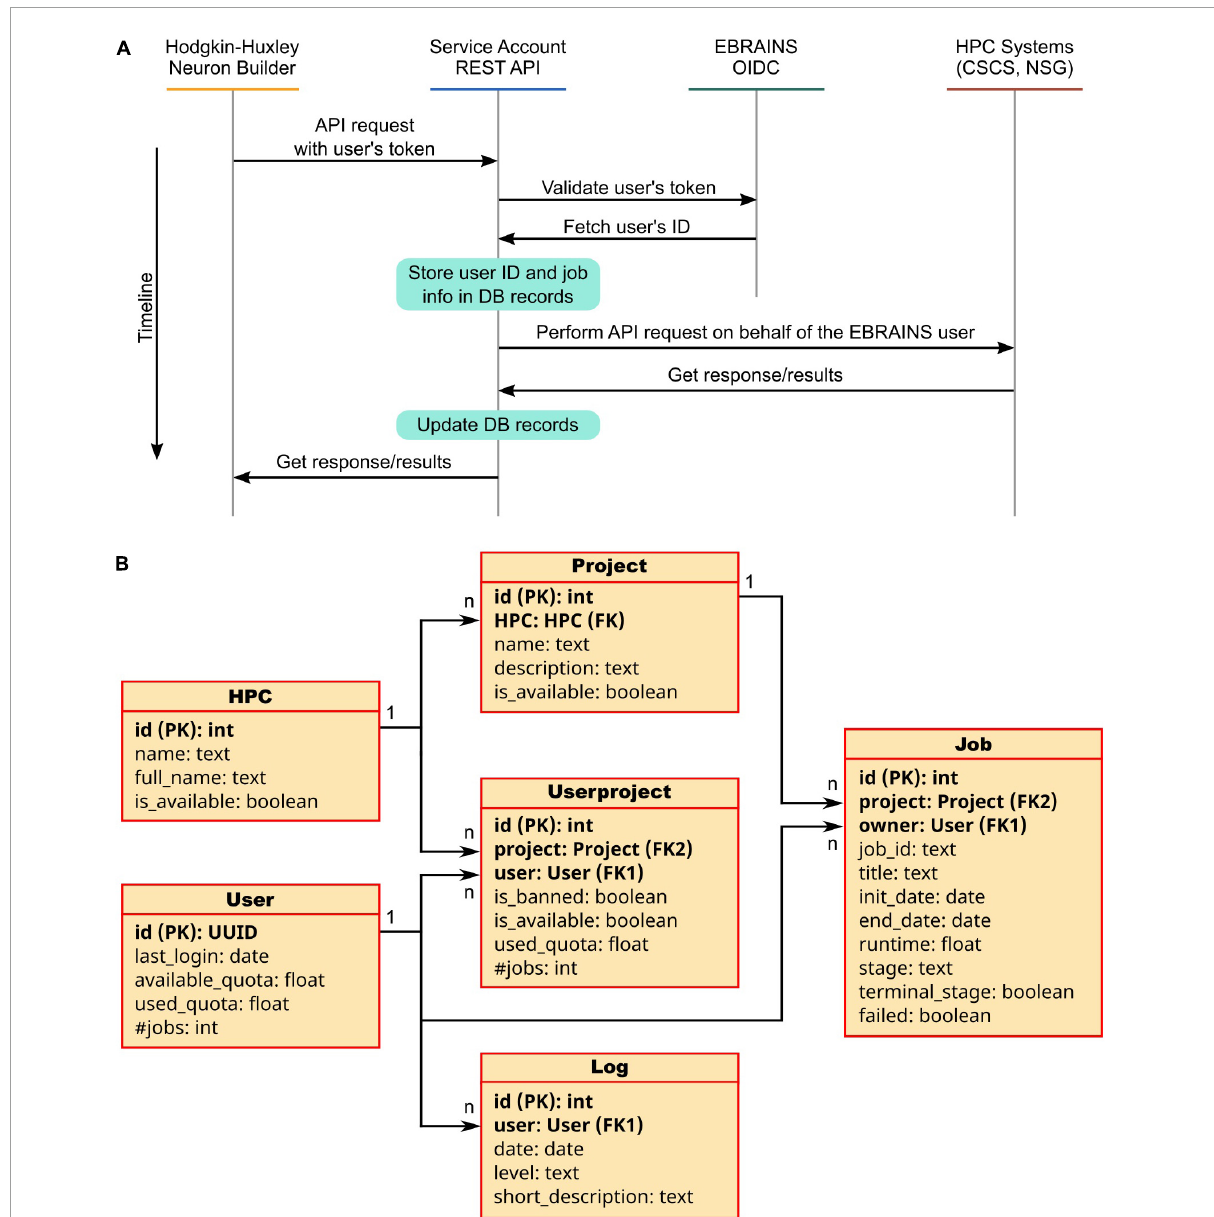
FIGURE6 The Service Account Utility. (A) Service Account workflow: once logged in to the EBRAINS authentication system, a user token is generated and sent to the Service Account server. Here, the EBRAINS OIDC engine is queried to check the validity of the token. Information on the job to be submitted (e.g., quota, job id, time requested) are stored in the Service Account database. The job is then submitted on behalf of the user to the HPC system. Once the job is completed, the Service Account APIs allow to fetch the results and provide them to the user in a transparent